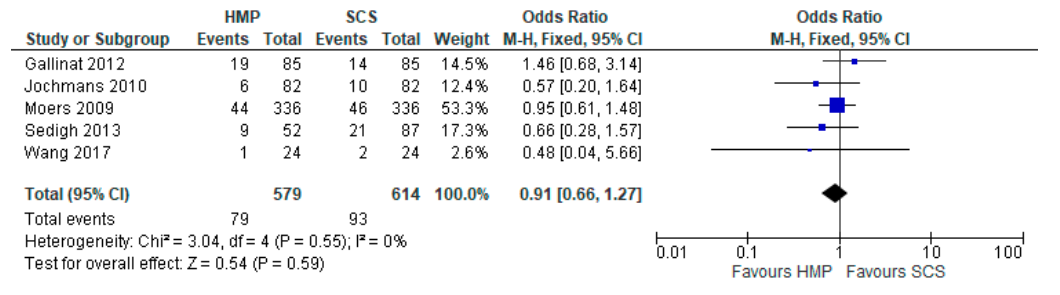
Figure 5. Acute rejection in Kidneys preserved via HMP and SC.